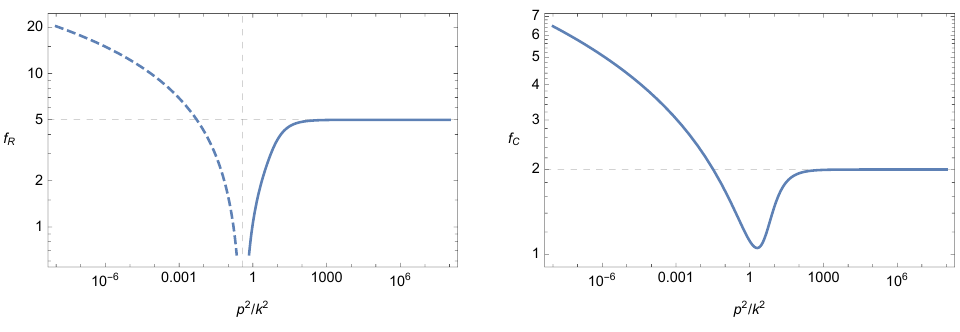
Figure 7. Background form factors f R and f C for the choices g = 1, Λ = 0, f R ( ∞ ) = 5, f C ( ∞ ) = 2 and the regulator (83). The dashing indicates that the function is negative in that regime. This choice of integration constants avoids additional poles in the propagator. For clarity, we have reinstated k in the momentum